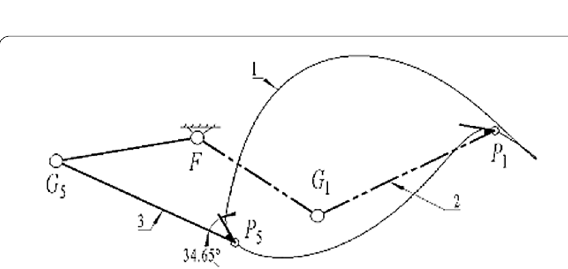
Figure 5 Schematic of the seedling pick-up mechanism calculated from the five key points: 1. Trajectory of seedling pick-up, 2. Key point 1 on rod II, and 3. Key point 5 on rod II